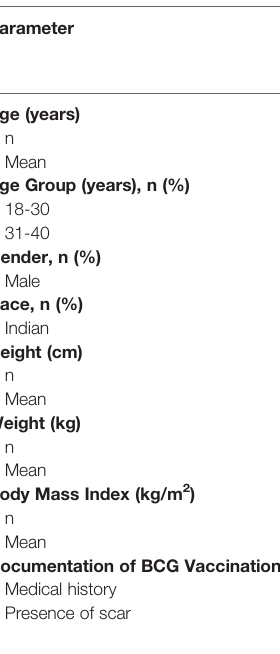
TABLE 1 | Demographic and Baseline